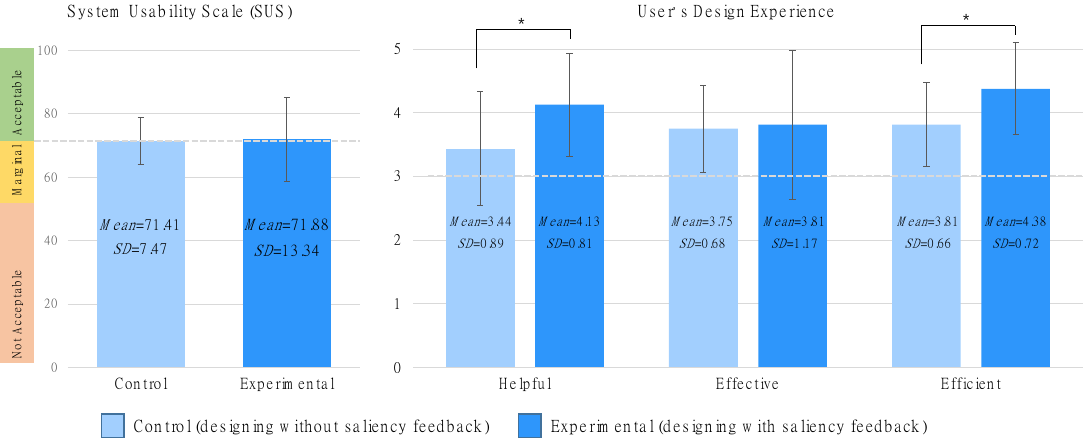
Figure 10. SUS scores and users’ design experience for the experimental group with saliency pre- diction and the control group without saliency prediction (* p < 0.05). The design process with the saliency map was perceived to be significantly more helpful and efficient than that without the saliency map.